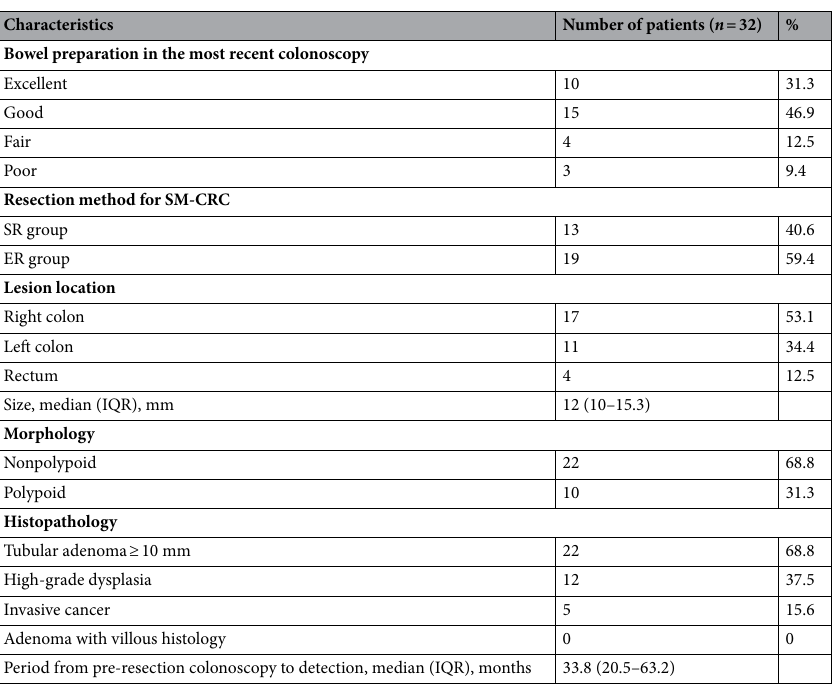
Table 2. Clinicopathological characteristics of metachronous advanced neoplasia after resection of submucosal invasive colorectal cancer. ER endoscopic resection, IQR interquartile range, SM-CRC submucosal invasive colorectal cancer, SR surgical